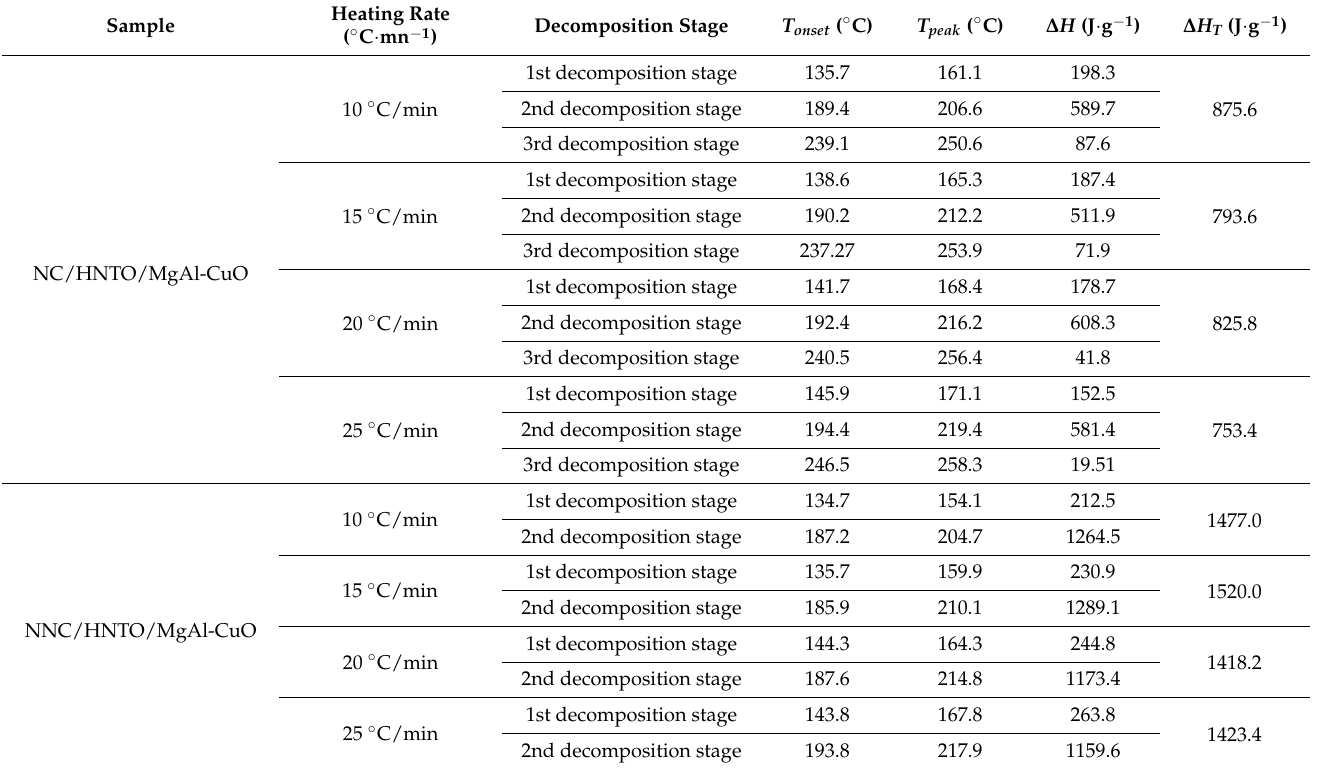
Figure 4. DSC curves of the ( a ) NC/HNTO/MgAl-CuO and ( b ) NNC/HNTO/MgAl-CuO composites at different heating rates. Table 1. DSC parameters of the NC/HNTO/MgAl-CuO and NNC/HNTO/MgAl-CuO